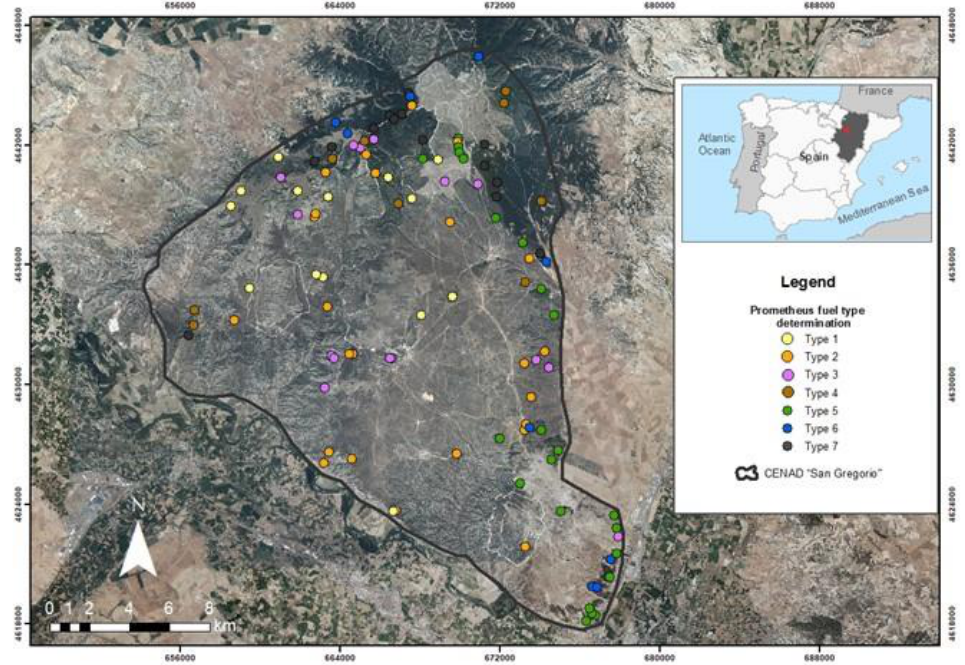
Figure 1. Study area with the location of field plots. The high spatial resolution orthophotography is provided by the Spanish National Plan for Aerial Orthophotography (PNOA). Table 1. Technical specifications of Airborne Laser Scanning (ALS) data. RMSEz stands for Root Mean Square Error in height, mJ stands for millijoule, e stands for Euler number, ns stands for na- noseconds, kHz stands for kilohertz.